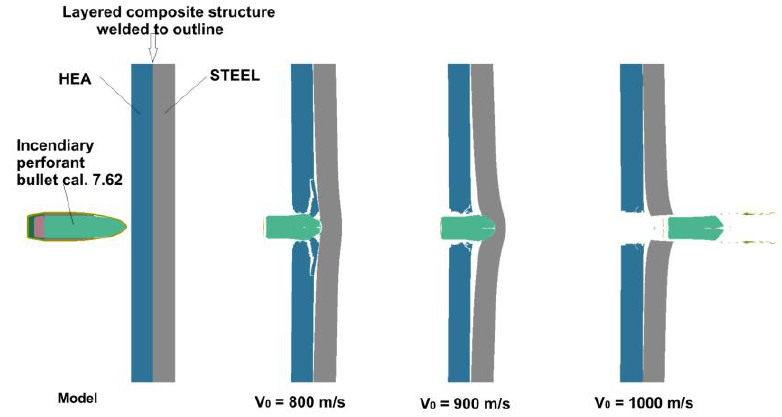
Figure 12. The behavior of the HEA-STEEL composite structure, welded by explosion, at impact with an incendiary armor piercing bullet (7.62 mm caliber) with different initial speeds.